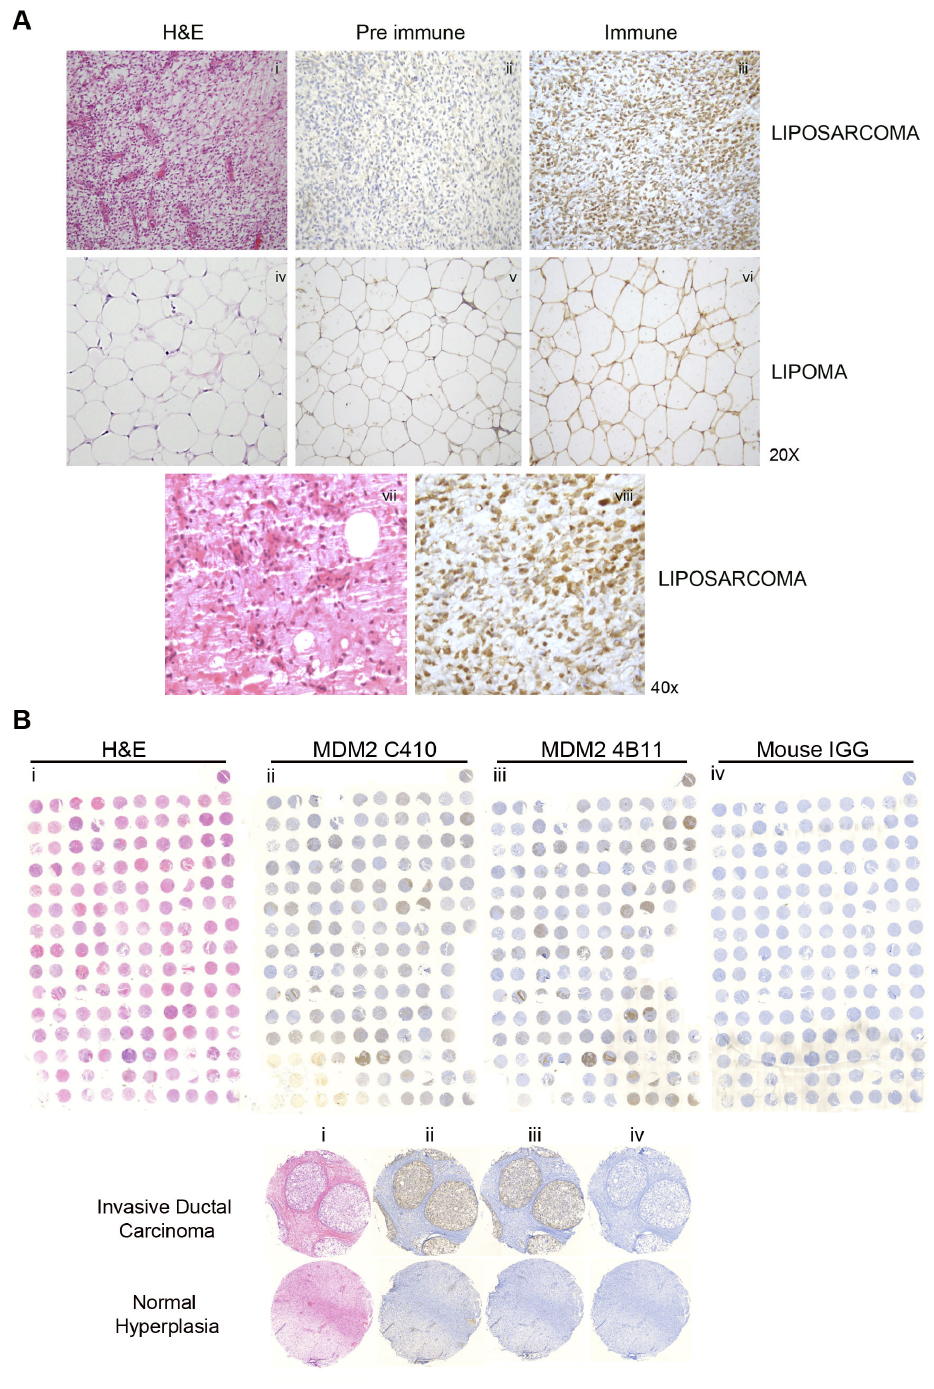
Figure 6. MDM2-C is highly expressed in liposarcoma and breast carcinoma tissues. A . Immunohistochemistry of lipoma and liposarcoma tissues using MDM2 C410 and pre-immune polyclonal serum antibodies. Biotinylated secondary antibody, ABC Reagent and DAB from Vector Labs were used. Pictures were obtained at 20X and 40x magnification. H&E refers to Hematoxylin and Eosin counterstaining. B . Breast tissue arrays (TMA-1008) were purchased from protein biotechnologies and automated histology was performed at the Molecular Cytology Core Facility at Memorial Sloan Kettering Cancer Center. Antibodies MDM2 C410 and MDM2 4B11 were used for staining. Mouse IGG was used for negative staining. H&E refers to Hematoxylin and Eosin counterstaining. doi: 10.1371/journal.pone.0077643.g006 PLOS ONE |